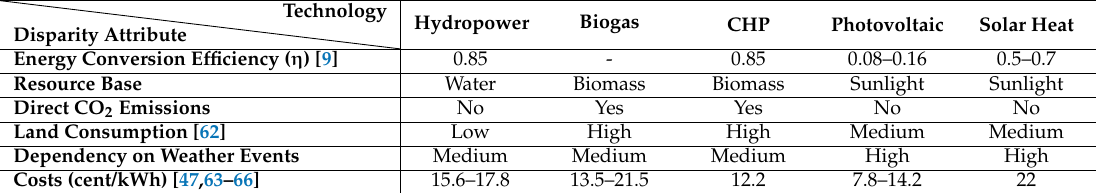
Table 5. Disparity attributes of energy production technologies employed in EWG (adapted from